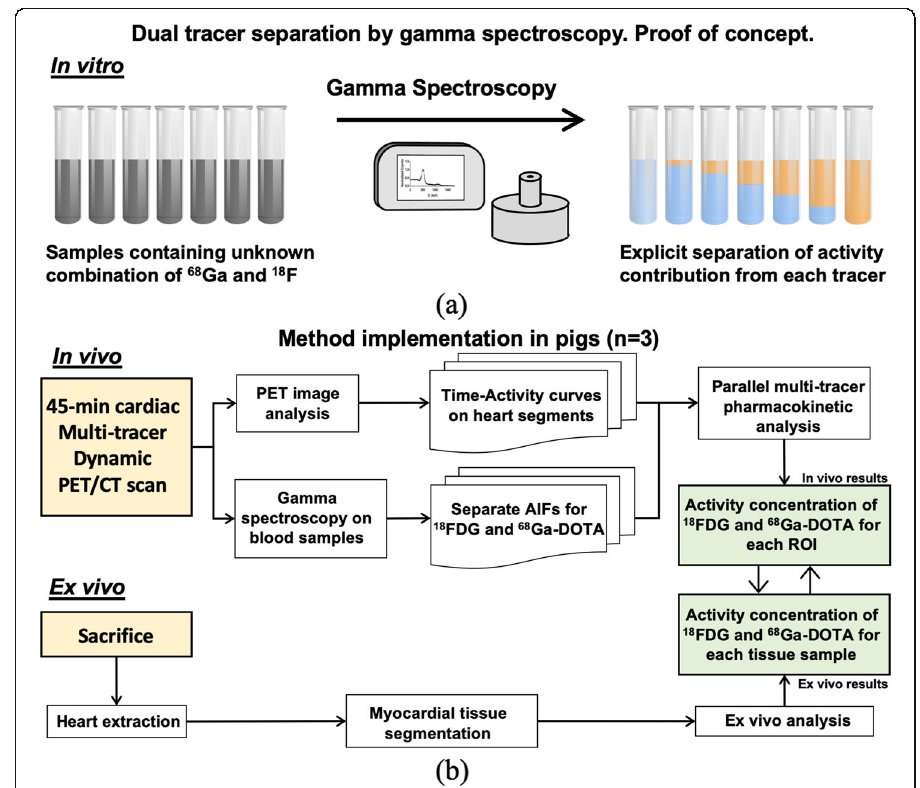
Fig. 1 Schematic drawing of the study design. a Firstly, our proposed tracer separation methodology based on gamma spectroscopy was evaluated in vitro as a proof of concept. A calibration protocol was established to obtain the activity concentrations of each radioisotope for samples containing an unknown combination of 18 F and 68 Ga. b Afterwards, this methodology was implemented in vivo. To do so, three pigs underwent 45-min cardiac dynamic PET/CT scans in which 68 Ga-DOTA and 18 FDG were injected with a 5-min time gap. After PET/ CT examinations, the animals were sacrificed, and their hearts excised, divided into segments, and analyzed to obtain the activity concentration of 18 FDG and 68 Ga-DOTA inside each segment. These results were compared against those obtained in vivo by parallel multi-tracer pharmacokinetic on the same regions of interest (ROIs) of their hearts. Explicitly separated AIFs needed for the pharmacokinetic analysis were obtained with our proposed method by gamma spectroscopy of a set of blood samples withdrawn during the